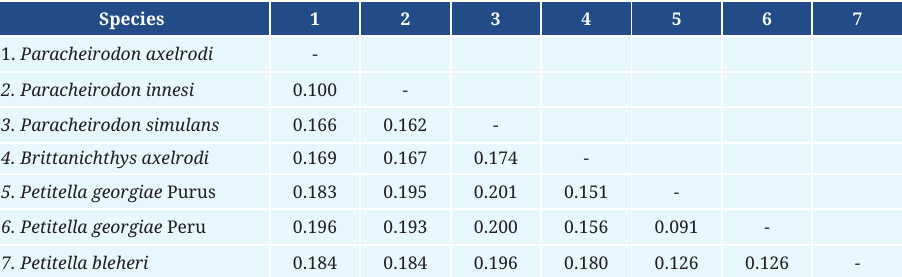
TABLE 2 | Uncorrected pairwise p-distance between species of Paracheirodon , Brittanichthys axelrodi . Petitella georgiae and Petitella bleheri . Distances were calculated using a 678 bp fragment of the citochrome C oxidase subunit I